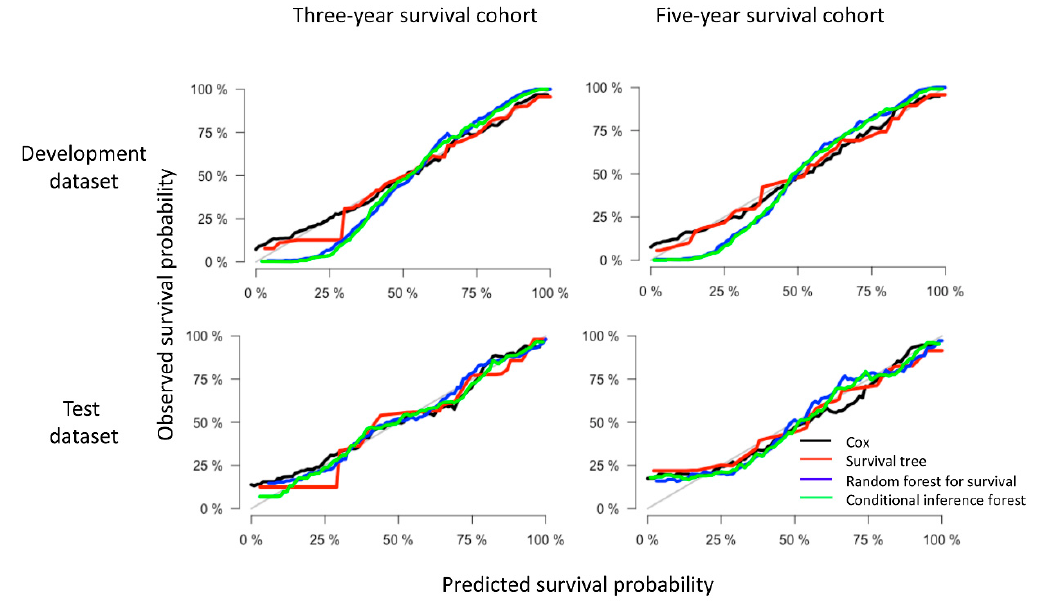
Figure 4. Example of calibration plots for predicting 3- and 5-year disease-specific survival of oral and pharyngeal cancers with various models (Cox regression, survival tree (ST), random forest for survival (RF) and conditional inference forest (CF)). The 45-degree straight line represents the perfect match between the observed (y-axis) and predicted (x-axis) survival probabilities. A closer distance between two curves indicates higher accuracy.